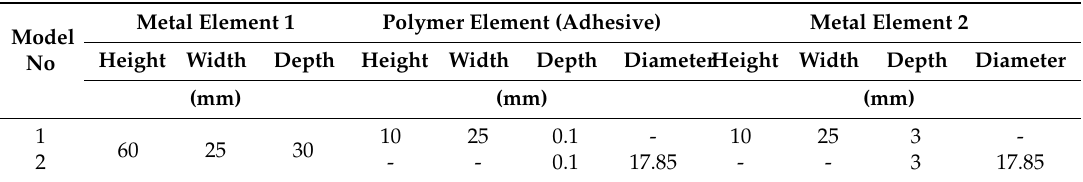
Table 2. The geometric dimensions of the 3D models adopted for the numerical calculations.